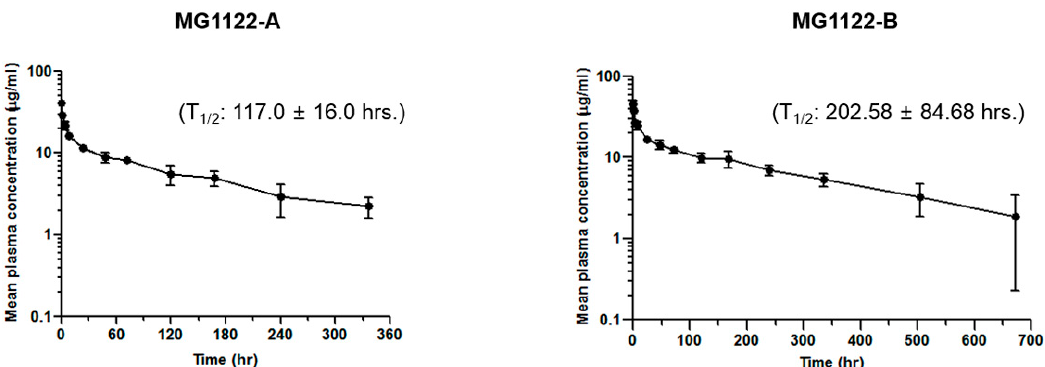
Figure 5. Serum half-life of bispecific antibodies. Serum concentrations of bispecific antibodies after injection of 3 mg/kg into six nude mice. Blood was sequentially collected at 5 min to 336 or 672 h after injection to measure serum MG1122-A or MG1122-B IgG concentrations, respectively. Each point represents the mean ± SD of six mice. i.v., intravenous injection.